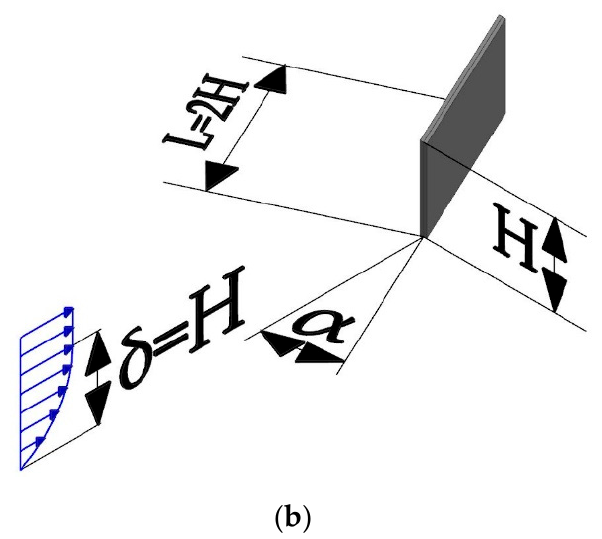
Figure 1. ( a ) Computational domain (not to scale). ( b ) Vortex Generator (VG) dimensions. For data extraction 12 points and 12 spanwise planes normal to the streamwise direction are considered. The planes are located from 3H to 25H of the LE (Leading Edge), separated 2H between each other. The points are located on the planes, downstream the TE (Trailing Edge) of the VG, at a height of 1H from the